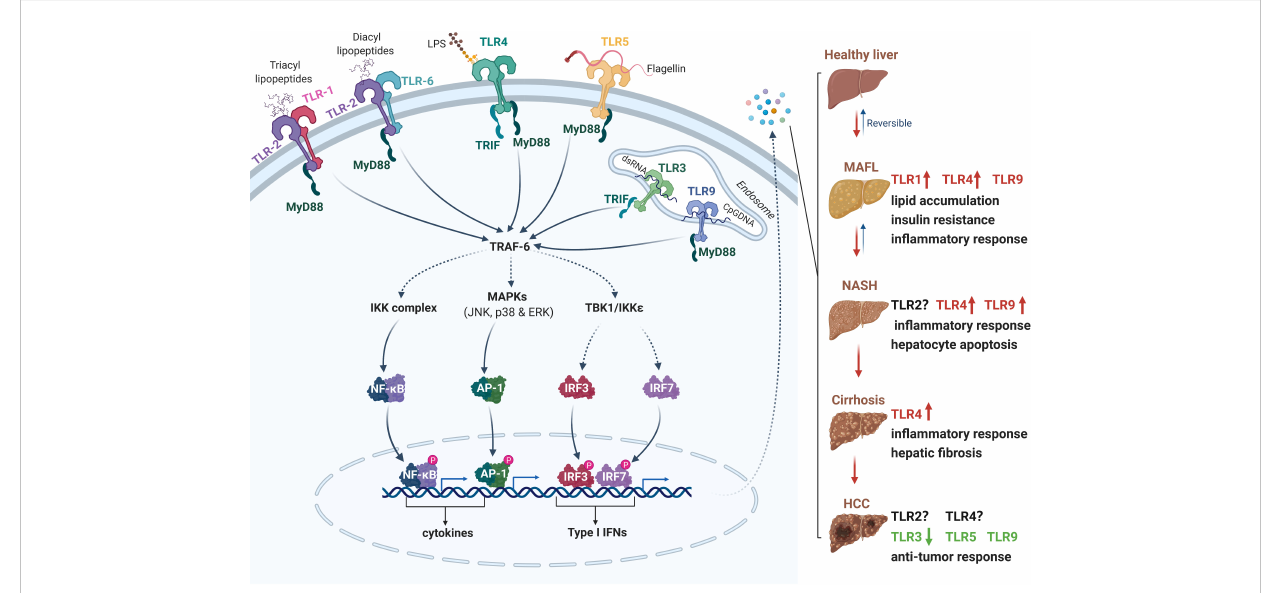
FIGURE 1 The role of Toll-like receptors (TLRs) in the pathogenesis of NAFLD and HCC. Following excessive high-fat diet intake and liver injury, PAMPs (e.g., LPS, fl agellin, lipopeptides and DNA) from microbes and DAMPs released from damaged or dying cells are accumulated in the liver. TLRs recognize PAMPs and DAMPs and initiate downstream cascades in TRIF- or MyD88-dependent manner. The activation of IKK, MAPKs and TBK1 kinases trigger dimerization and translocation of NF- k B, AP-1 and IRF3/7 respectively, then induce the expression of several cytokines, chemokines, type I interferons, and other pro-apoptotic genes. The secretion of these active factors may contribute to insulin resistance, lipid accumulation, in fl ammation, hepatocyte apoptosis or anti-cancer responses. Different TLRs play diverse roles in the process of NAFLD to HCC. PAMPs, pathogen- associated molecular patterns; DAMPs, damage-associated molecular patterns; TRIF, TIR-domain-containing adapter-inducing interferon b ; MyD88, myeloid differentiation primary response 88; IKK, I k B kinase; MAPK, mitogen-activated protein kinase; TBK1, TANK-binding kinase 1; NF- k B, nuclear factor kappa B; AP-1, activator protein 1; IRF, interferon regulatory factor. Red, accelerative effect; Green, protective